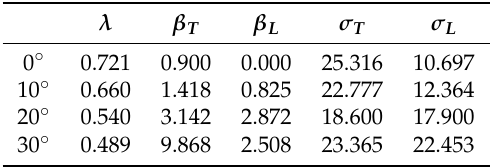
Figure 4. All of the SNR values, apart from TO + (all azimuths) and LO + (20 ◦ and 30 ◦ ), were close to the experimental data. Table 3. Estimated λ , β T , β L , σ T and σ L